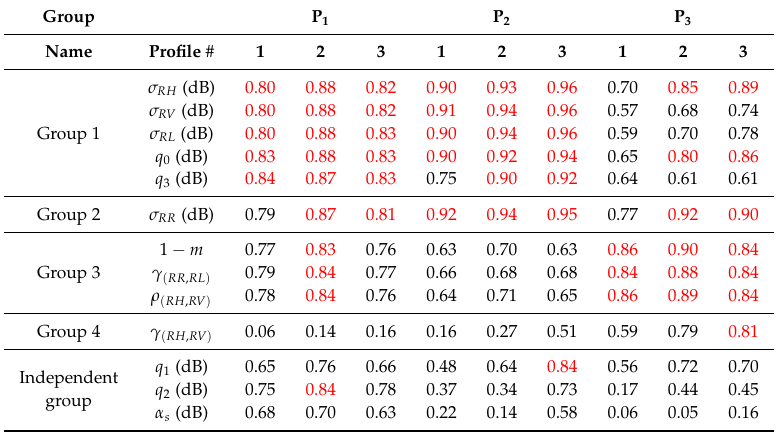
Table 4. The Spearman’s correlation coefficient ( r s ) (absolute value) between RI-1 and RS-2 for the three profiles in each pair (seen Figure 5). The r s values that are above 0.8 (strong correlation) are colored red. The first column shows the groups as described in Table